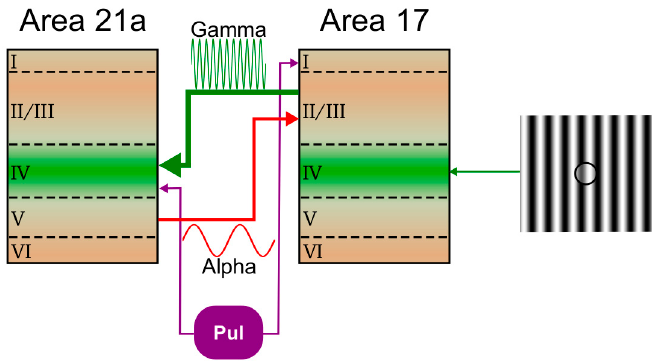
Figure 7. LPl control of feedforward and feedback processing in the early visual cortex system of cats. Putative wiring diagram for the frequency and layer-specific feedforward and feedback processing in which the area 17 receptive field is stimulated with a sinusoidal drifting grating. The LPl inactivation resulted in increased neuronal synchronization in the gamma band promoting a feedforward drive from area 17 to 21a (thick green line). Feedback coupling from area 21a to area 17 in the alpha band (thick blue line) is also increased during the pulvinar inactivation. The feedback processing may be mediated by NMDA receptors. The pulvinar could synchronize selectively neurons from area 17 to 21a to attend a visual stimulus, choosing the relevant feedback route to amplify the feedforward path.